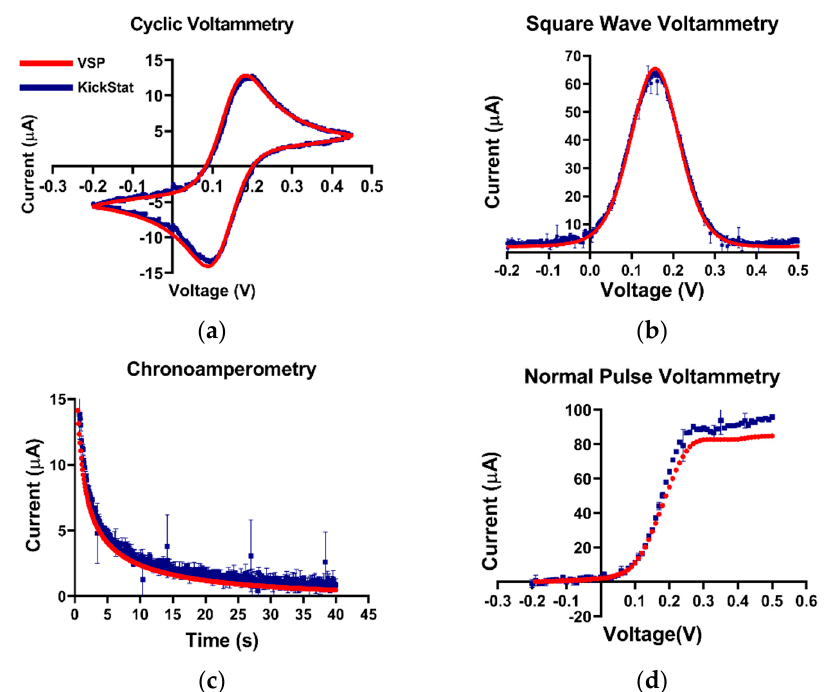
Figure 3. Quantitative comparisons between KickStat (blue) and the commercial device (red) while measuring 5 mM potassium ferricyanide with different electrochemical techniques. ( a ) Cyclic voltammetry, ( b ) square wave voltammetry, ( c ) chronoamperometry, and ( d ) normal pulse voltammetry. Peak values of the current are within 9% for each measurement across each electrochemical technique. Each data point shown for each device is the average of 3 sequential runs. Error bars represent standard deviation and are smaller than the points plotted. Voltages are referenced against an Ag / AgCl reference electrode.